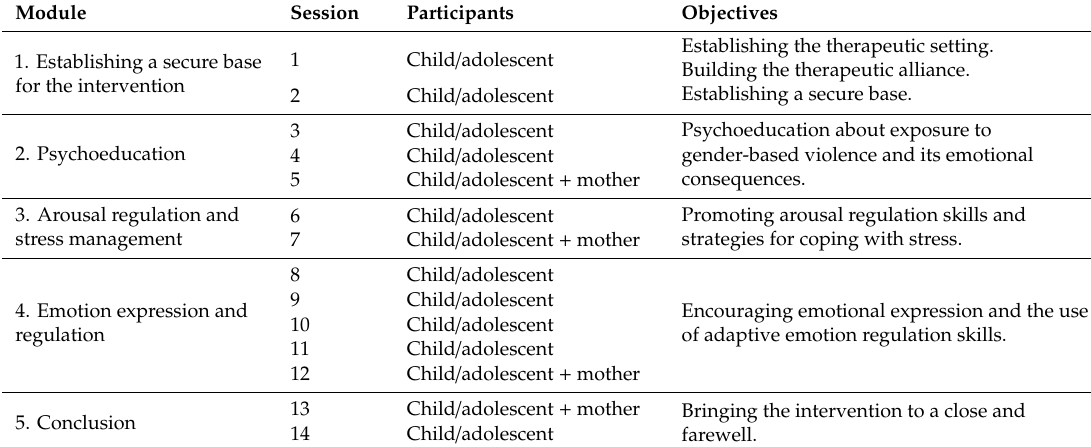
Table 1. Summary of the Leaving a Mark